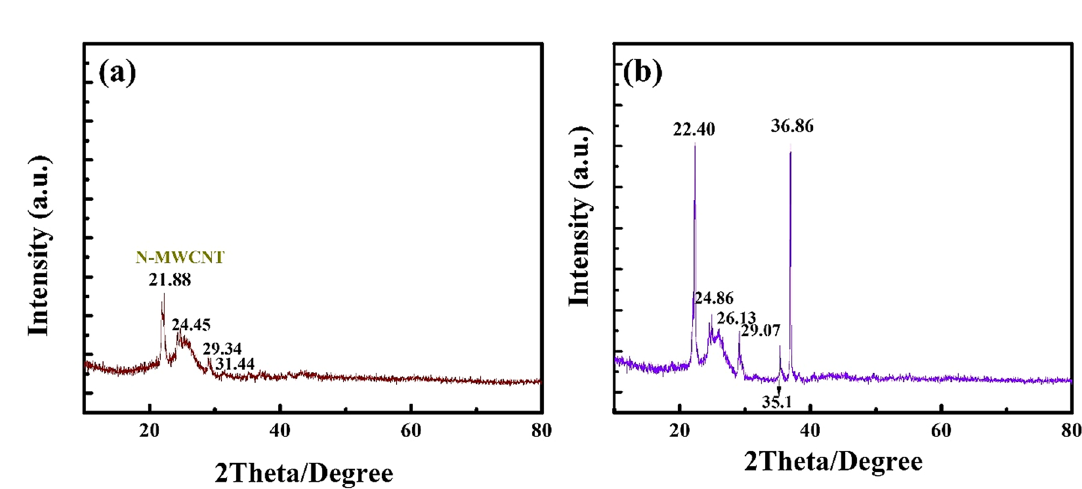
Figure 3. XRD results of the ( a ) N-MWCNT and ( b ) N-MWCNT/CMC